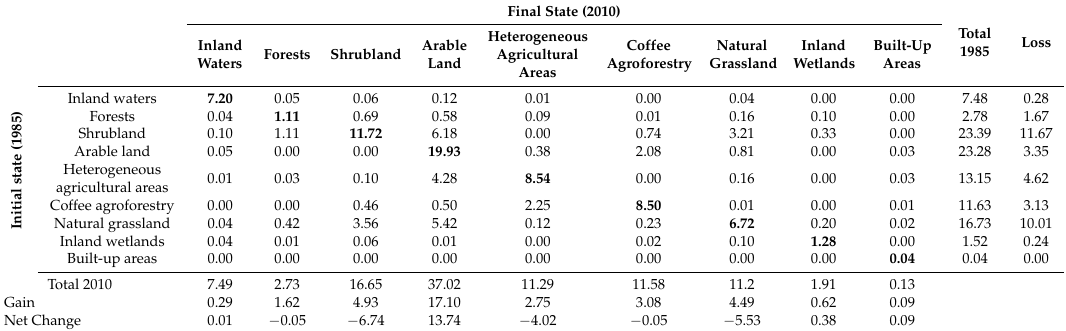
Table 5. Transition matrix showing LULC changes (%) in ACB between 1985 and 2010.